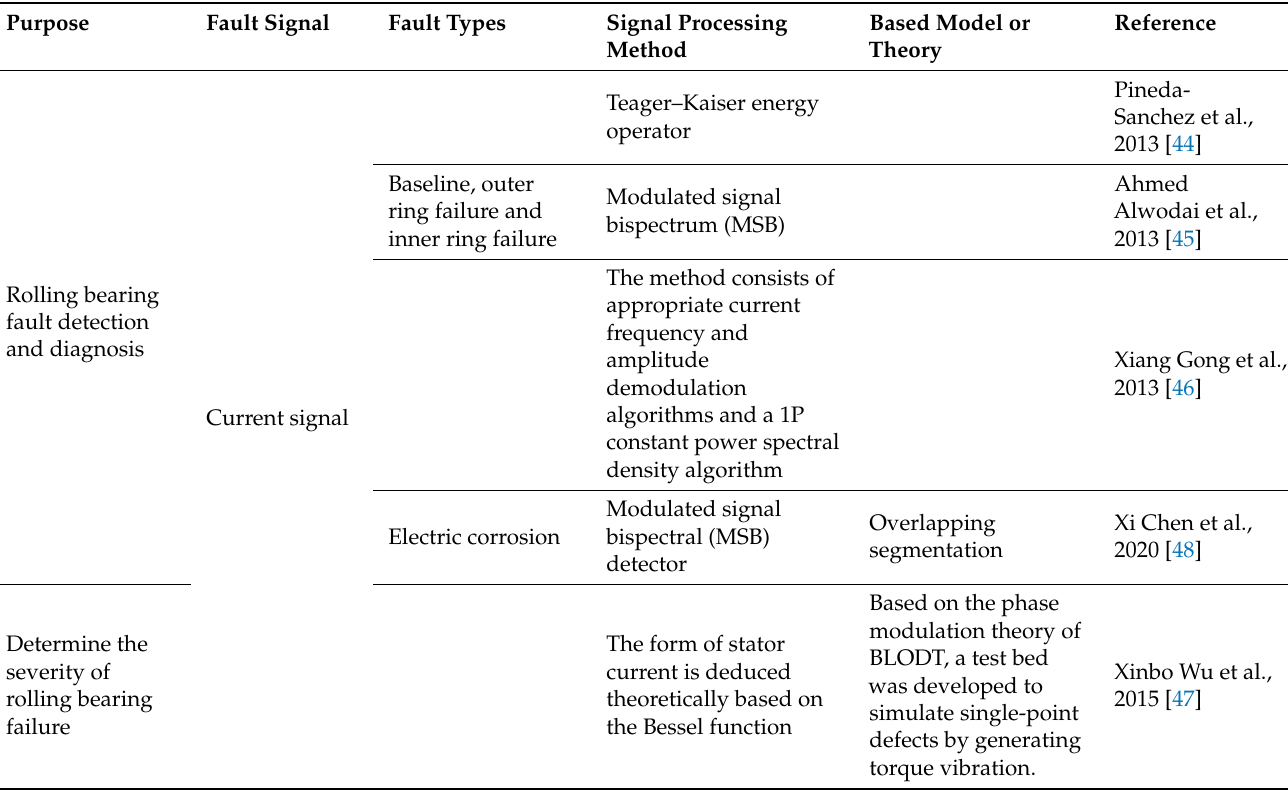
Table 3. Summary and comparison table of demodulation transformation